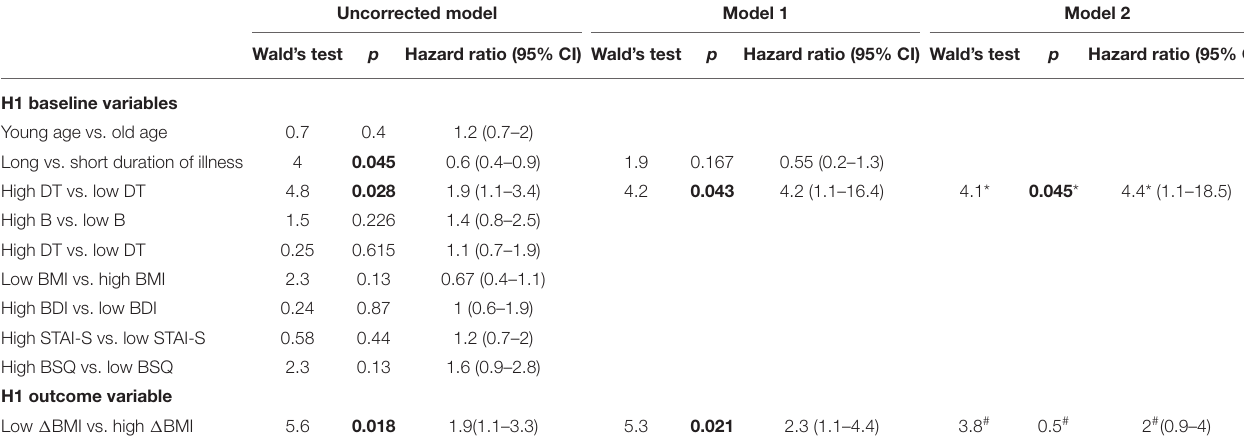
TABLE 3 | Predictors of time-to-readmission in anorexia